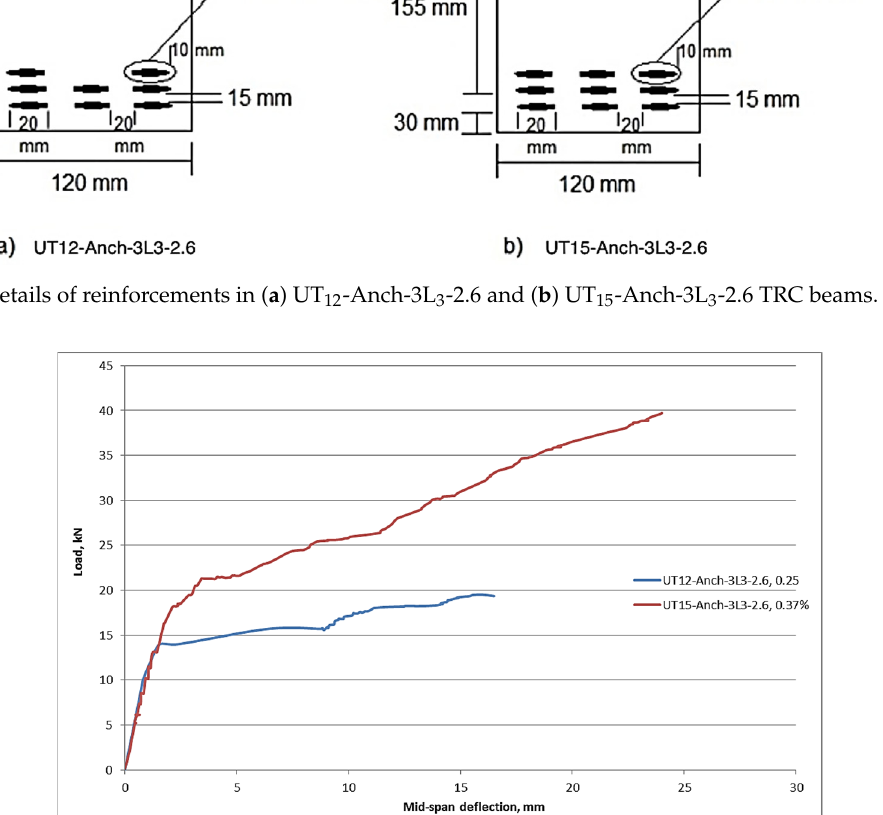
Figure 19. Mid-span load-deflection of UT 15 -Anch-3L 3 -2.6 and UT 12 -Anch-3L 3 -2.6 TRC beams.